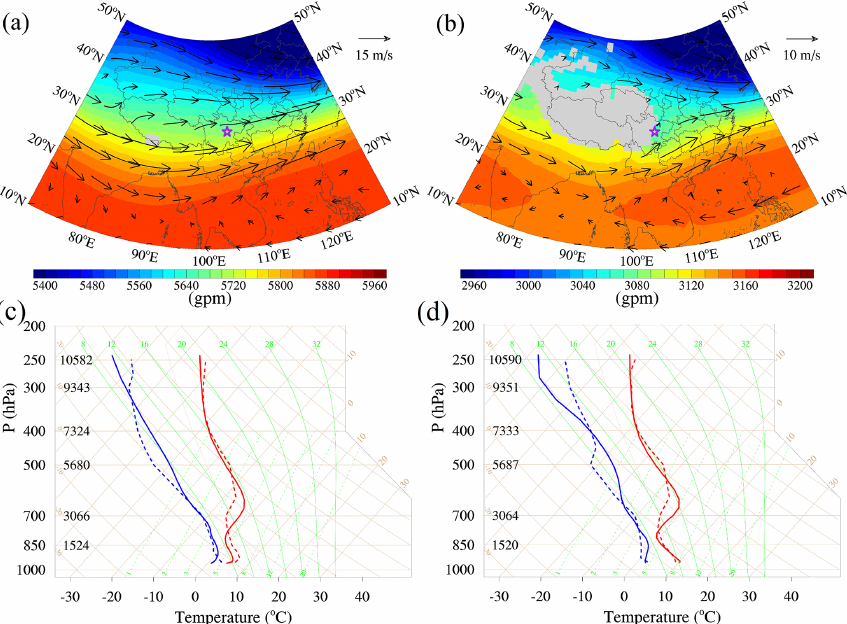
Figure 4. The weather charts at (a) 500hPa and (b) 700hPa for January 2017 are based on the NCEP FNL reanalysis data. The purple stars show the location of Chengdu. Panels (c) and (d) show the skew-T diagrams at 00:00UTC and 12:00UTC, respectively, in January 2017. The red and blue solid lines are the respective simulated air temperature and dew point temperature in the Jan_Base simulation, and the red and blue dashed lines are the respective sounding temperature and dew point temperature. These results are monthly averages.